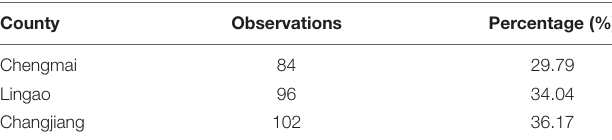
TABLE 1 | Description of sample